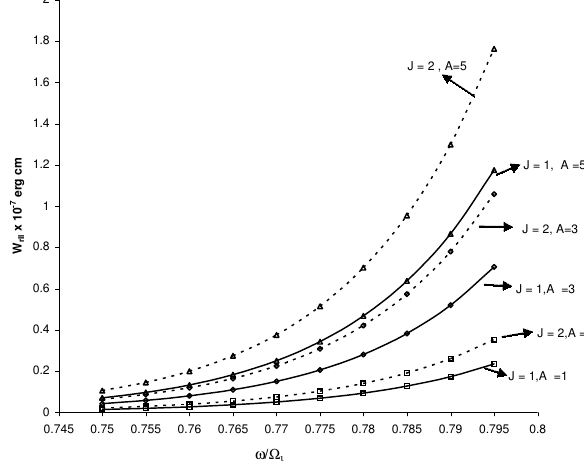
Fig. 6. Variation of parallel resonant energy W rII erg cm versus wave frequency ( ω / (cid:127) i ) for different values of anisotropy (A) and Fig.6 Variation of parallel resonant energy W rII erg cm versus wave frequency distribution index J =1, 2,V D = − 3 × 10 7 ( w / W i ) for different values of anisotropy (A) and distribution index J= 1,2 V D = -3 x 10 7 cm/sec.